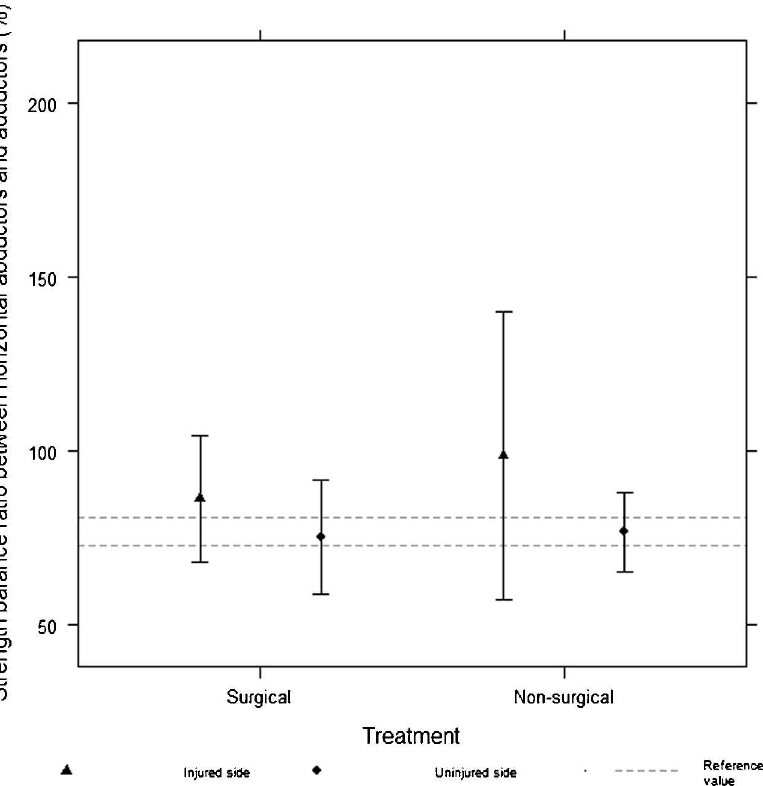
Figure 4 - Balance ratio between the horizontal abductor and adductor muscles of the shoulder for concentric action in athletes who underwent surgical and